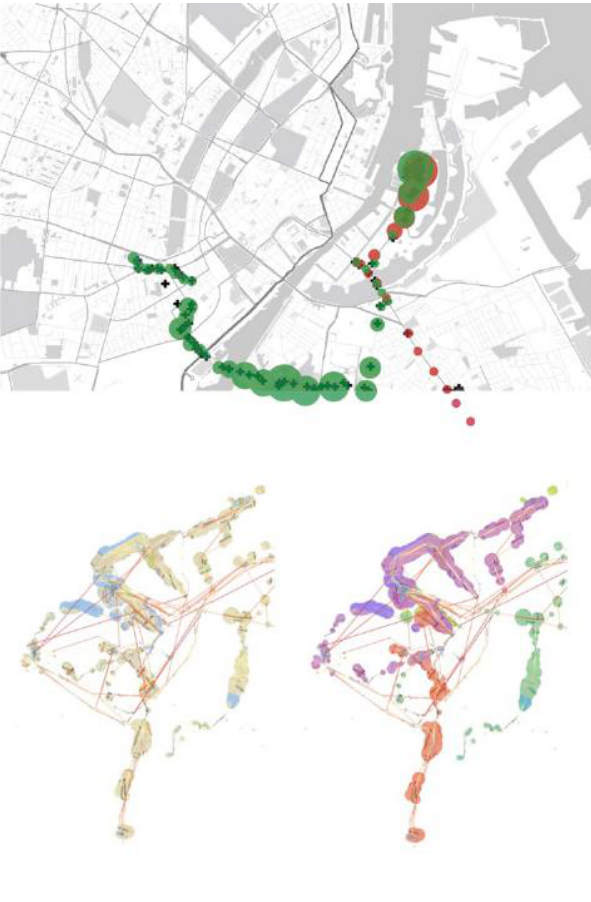
Figure 8: Bikers’ paths (clouds) and public transportation routes (red). The left-hand map juxtaposes public transportation routes on heavily trafficked streets with bike routes used to access the same locations. Colors on the right-hand map show different participants; gradations and hues indicate speed of travel. Image: N. Azel, G. Bouron, A.